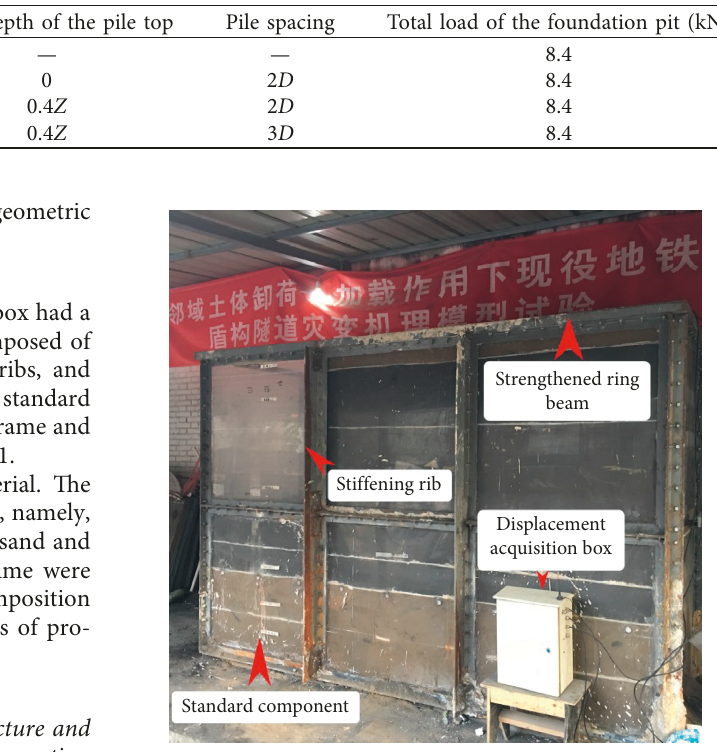
Table 2: Similar material model test schemes.